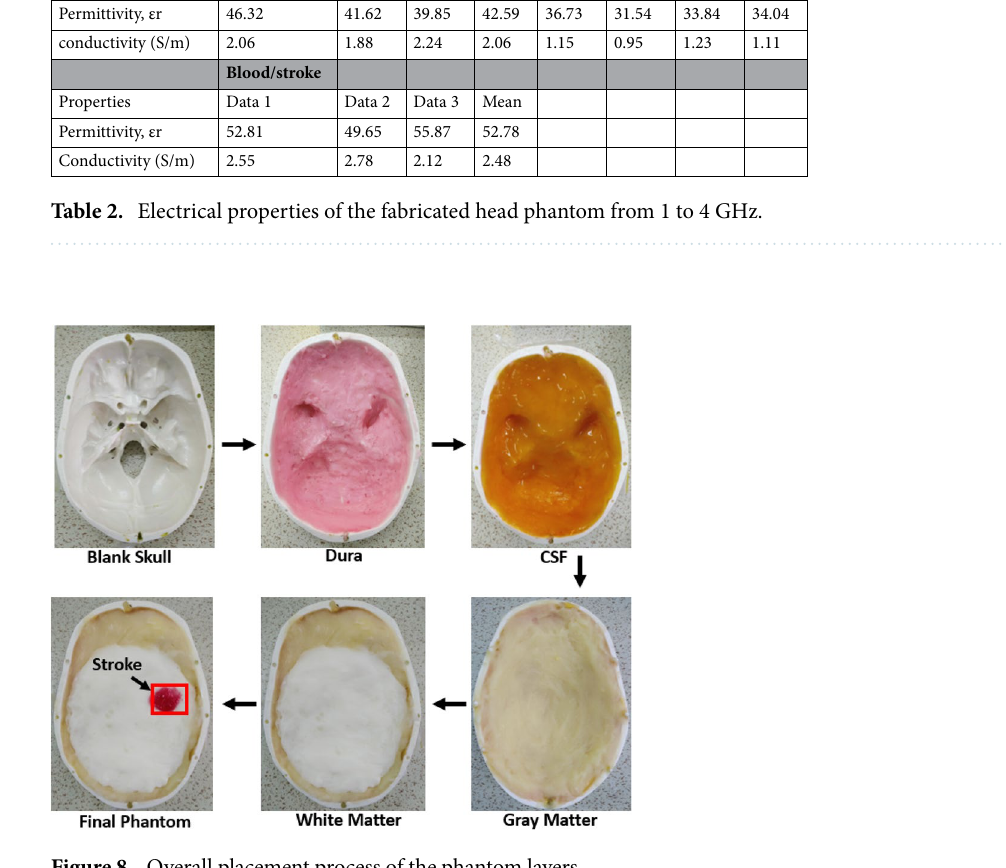
Fig. 8. Dura is the first component to be filled into it, which later continues with CSF, gray matter, white matter and blood, respectively. The rectangular mark represents the area of the stroke inside the head phantom, which is later analyzed through the IC-CF-DMAS image reconstruction algorithm to validate the phantom performance.